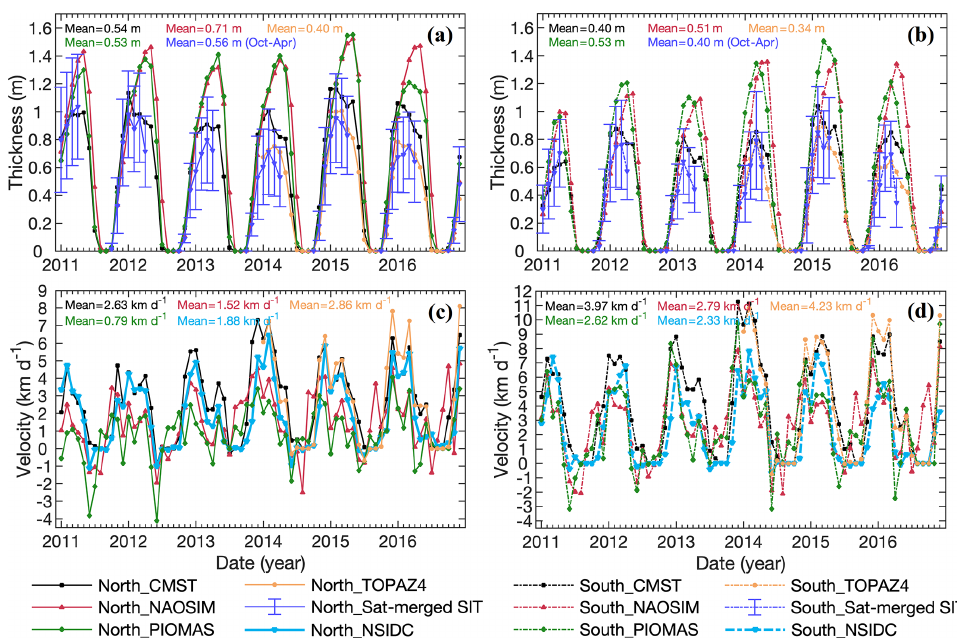
Figure 2. The monthly mean variations of sea-ice thickness and southward velocity over the northern inflow gate and southern outflow gate (SIT: a and b , SID: c and d ). The full lines in (a) and (c) and dashed lines in (b) and (d) represent sea-ice variables over the north gate and south gate, respectively. The different colors denote different input sea-ice data. Note that the Sat-merged SIT with corresponding uncertainty is from locally merged sea-ice data in the Baffin Bay.